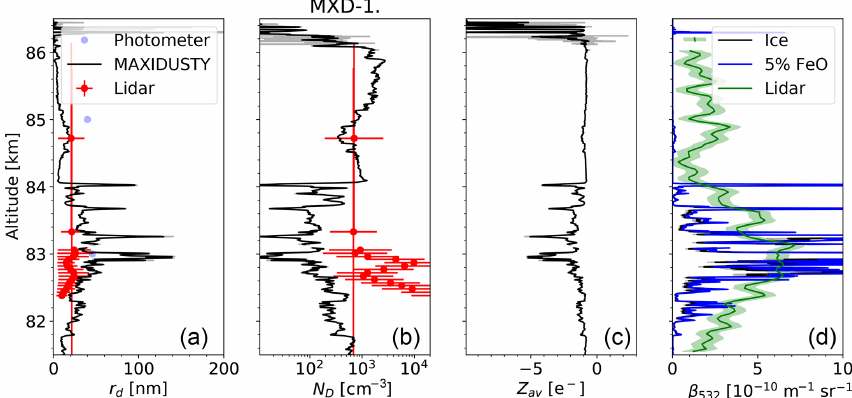
Figure 6. Panels (a) – (c) show results for r d , N D , and Z av for an assumed value of η S , ref = 100. RMR lidar results are marked by red dots while the two blue dots at 83 and 85km are for the MISU photometer. Panel (d) shows the observed lidar altitude profile in which the black curve shows model results computed based on the MAXIDUSTY data of panels 1 and 2 and the assumption of pure ice particles, and the blue curve shows results based on the assumption that the ice particles contain 5% FeO. The green shaded area indicates the measurement